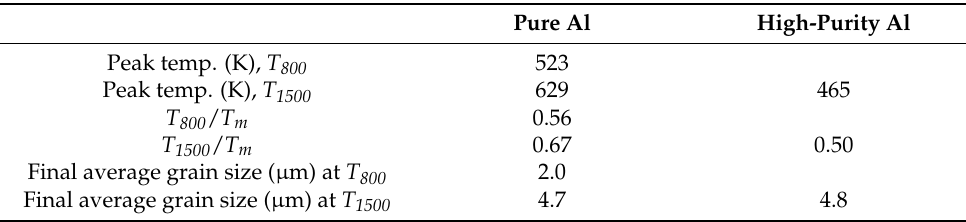
Table 2. Welding conditions and final average grain sizes for pure and high-purity Al, where T m denotes the melting point (933K) [26].